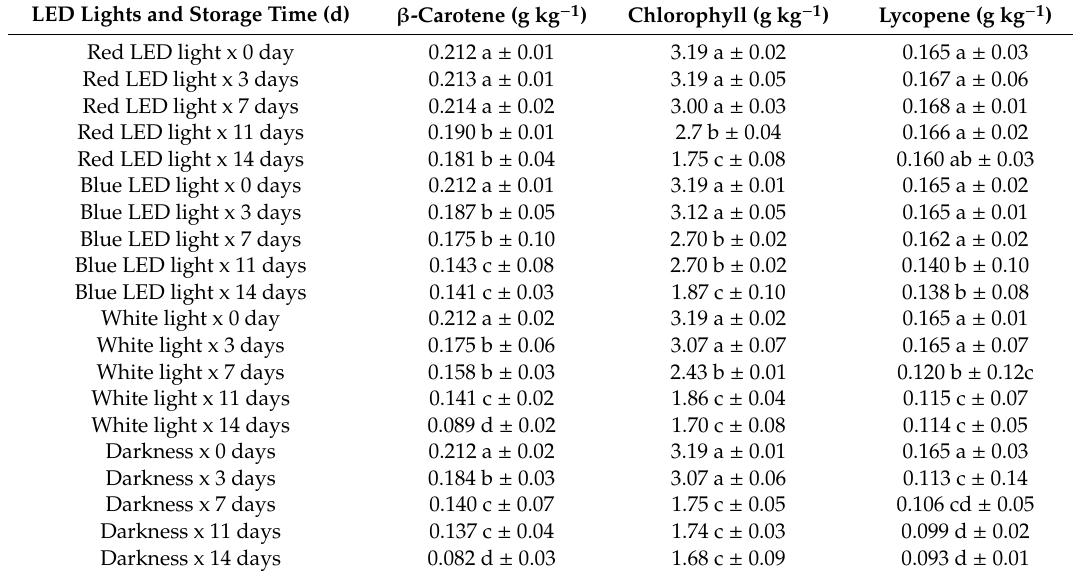
Table 1. Influence of red or blue LED lights and storage times from 0 to 14 days on β -carotene content in yellow sweet pepper, chlorophyll content in green sweet pepper, and lycopene content in red sweet pepper fresh-cuts at 7 ◦